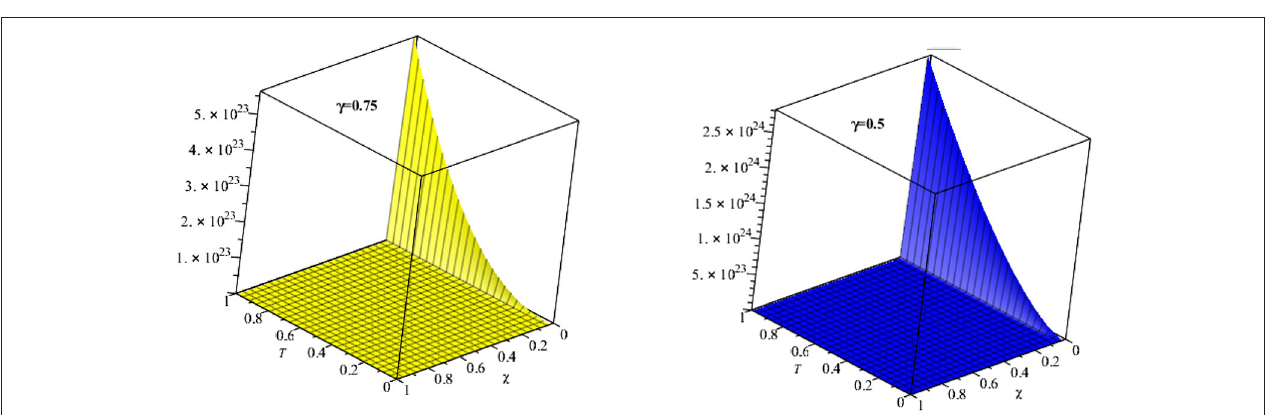
FIGURE 6 | Represents the exact and analytical solution of example 4.4.